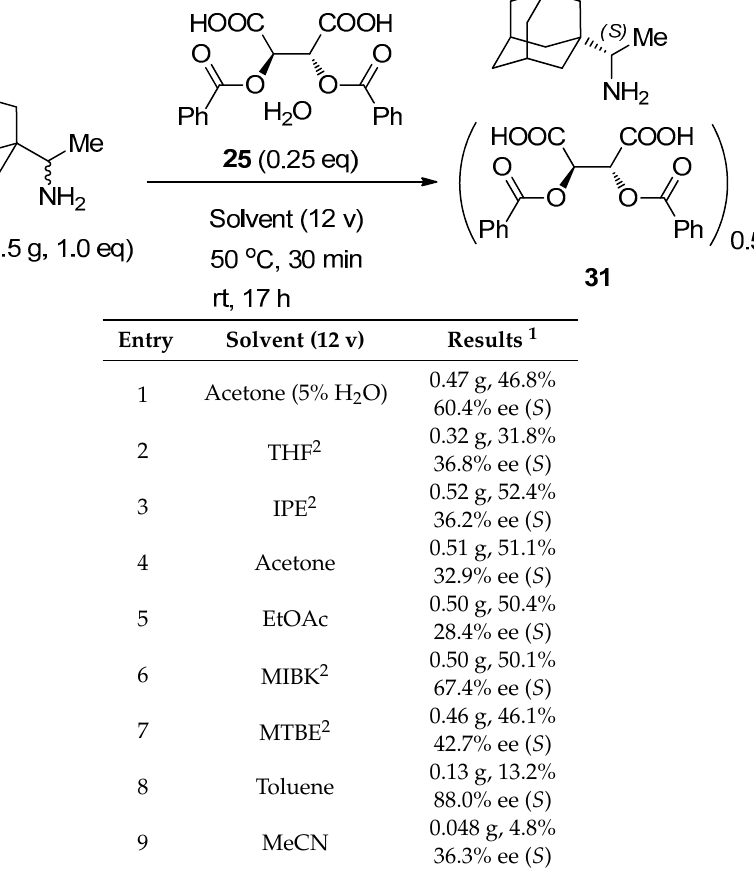
Table 2. The use of 0.25 equivalents of (2 R ,3 R )-dibenzoyltartaric acid 25 in various solvents.